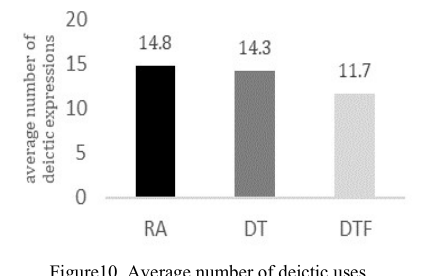
Figure10. Average number of deictic uses.